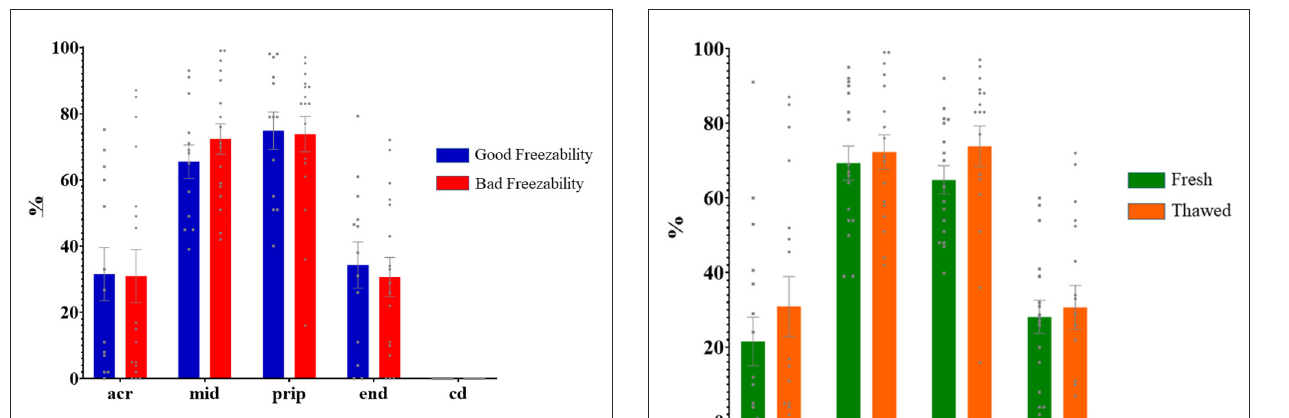
FIGURE3 Proportion (mean ± SEM) of frozen-thawed spermatozoa from ejaculates classified as of good (GFE) or poor freezability (PFE) with representative localization patterns of AQP3 in membrane domains. Acr, Acrosome; mid, midpiece; prip, principal piece; end, end piece; cd, cytoplasmic droplet.